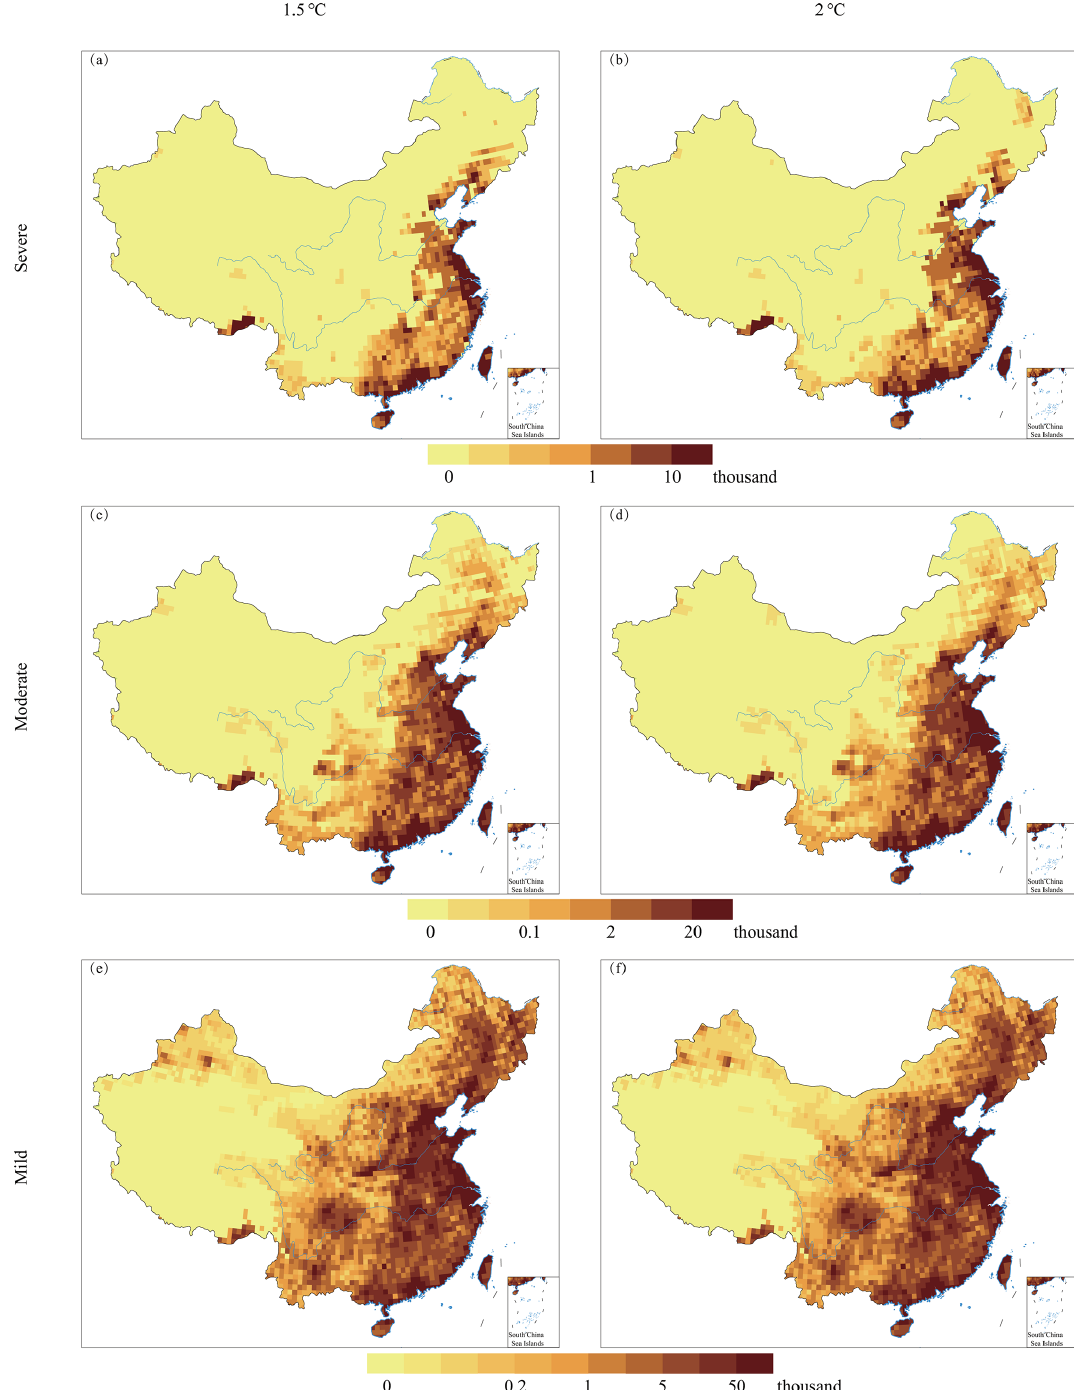
Figure 4. Spatial patterns of the population affected by severe (a–b) , moderate (c–d) and mild (e–f) floods for 1.5 ◦ C (a, c, e) and 2 ◦ C (b, d, f) of global warming under the RCP8.5